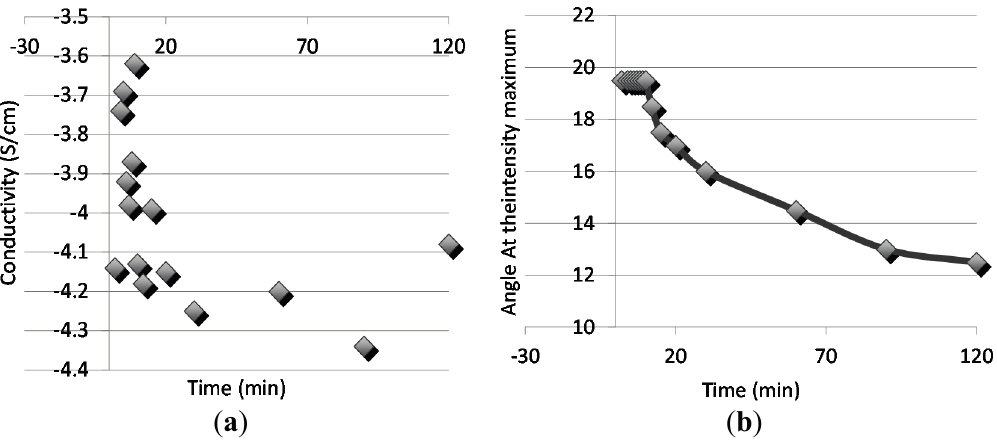
Figure 6. ( a ) Conductivity and ( b ) the scattering angle with the time for the phase